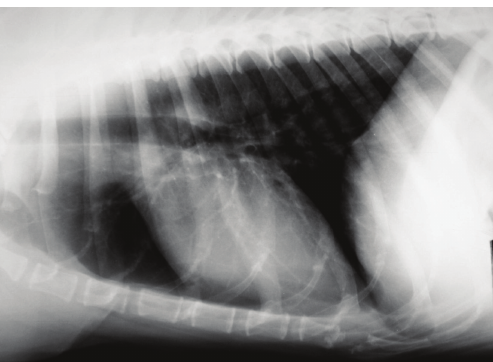
Figure 1: Thoracic radiograph laterolateral view showing the reduction of the cardiac silhouette (vertebral heart scale system score: 8.2) and pulmonary vascular hypoperfusion that both suggest reduction of plasmatic volume.